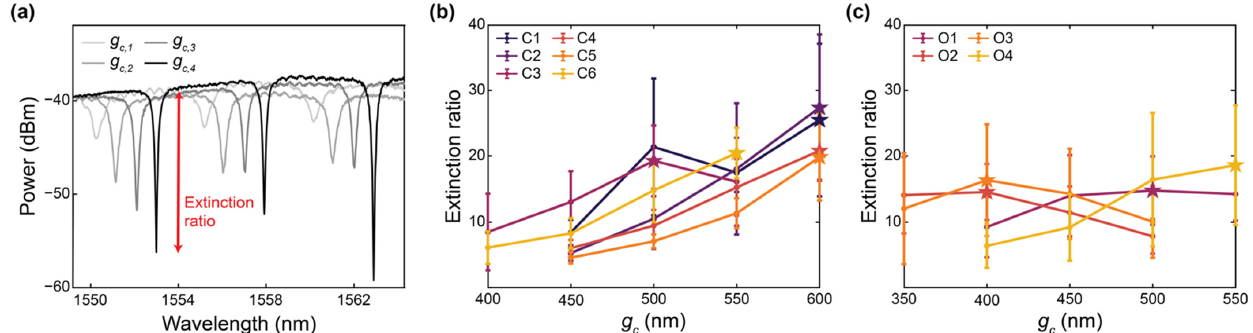
Figure 8. ( a ) Example spectra of four microring resonators with the same ring radii and waveguide geometries but different coupling gaps, leading to variations in resonance peak extinction ratios. Measured extinction ratios for ( b ) C-band and ( c ) O-band microring resonators as a function of coupling gap distance ( g c ). Star-shaped markers indicate designs which achieved the greatest extinction ratios for each waveguide geometry. All measurements were performed with water cladding. Extinction ratios for each sensor geometry were calculated from 0–13 resonance peaks per resonator (those peaks passing the R 2 > 0.85 threshold) analyzed over a wavelength range of 1530–1560 nm for the C-band devices and 1270–1310 nm for the O-band devices, with 1–2 replicate resonators on each of five replicate chips. Extinction ratios are reported as the mean ± one standard deviation. Further details regarding the number of included resonance peaks per resonator on each chip are provided in Table